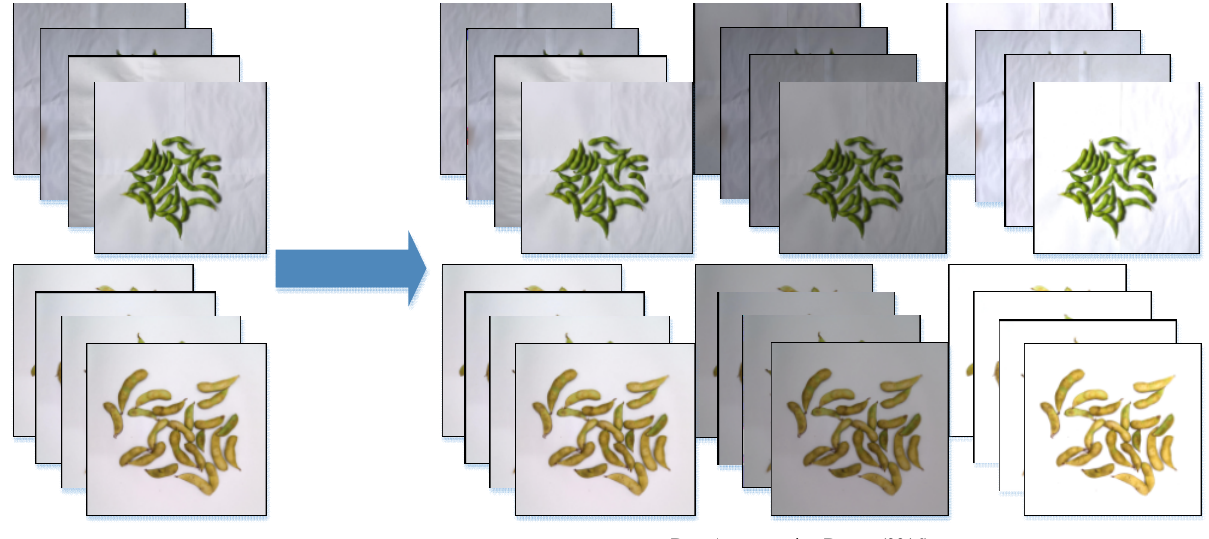
Figure 2. The number of training set images is expanded to 3216 by data augmentation.